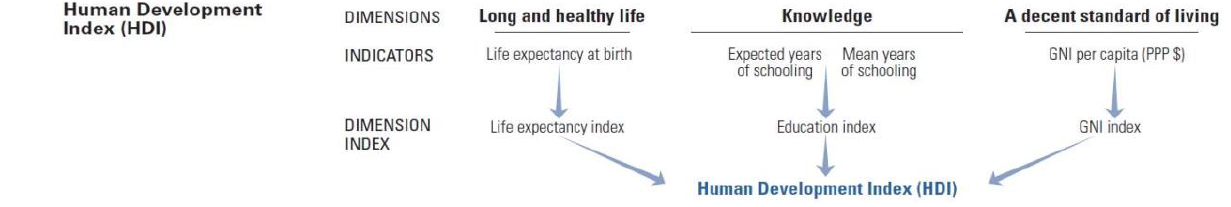
Figure 1: Human Development Index (HDI); Source: http://hdr.undp.org (Accessed: